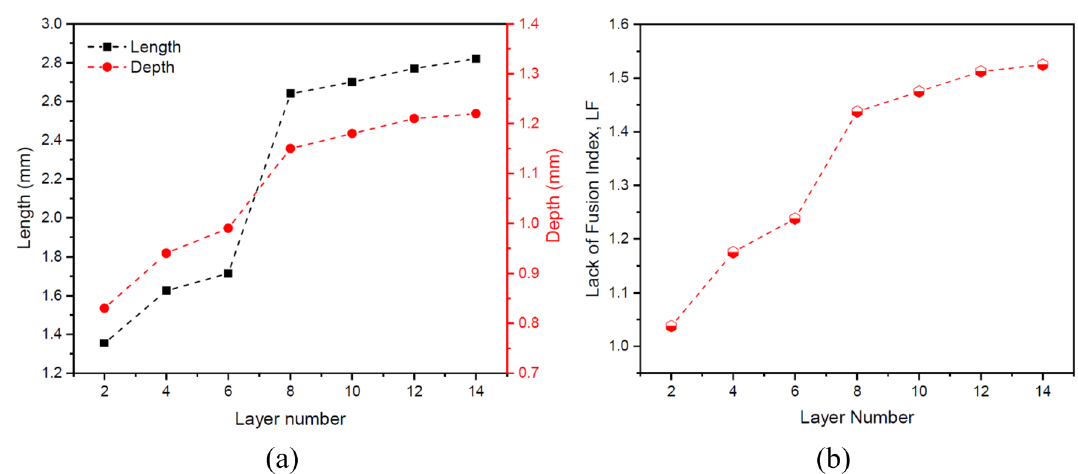
Figure 9. The variations of ( a ) the length and depth of the melt pool and ( b ) the LF index in the build